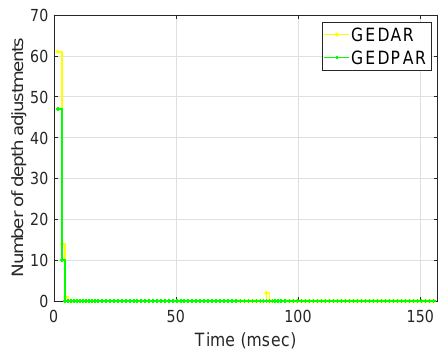
Figure 10. Depth adjustment.